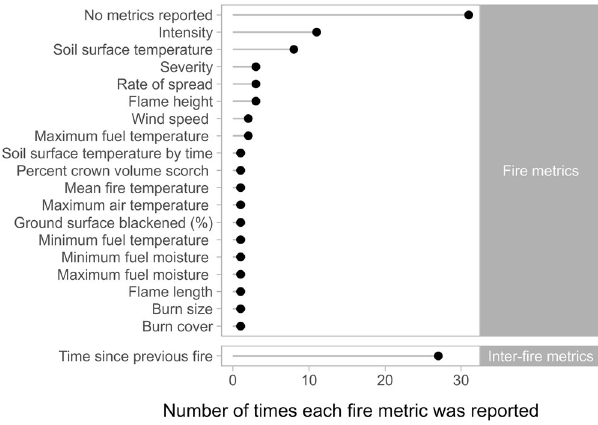
Fig. 4 Plant response interactions with characteristics of fi re and fi re regimes. The response of plants to fi res in different seasons may be in fl uenced by interactions with fi re severity, intensity, and time since previous fi re. To assess how impactful these interactions were on plant responses, we recorded all mentions of these fi re metrics from each of the sampled articles. No fi re metrics were recorded within 38 of the 53 target articles. Of the 53 articles only 26 mentioned time since previous fi re and only one article [109] used time since previous fi re in their experimental design. A total of 18 metrics were reported from the 53 articles and despite their similarities, no consistent metric was found to allow for comparisons between